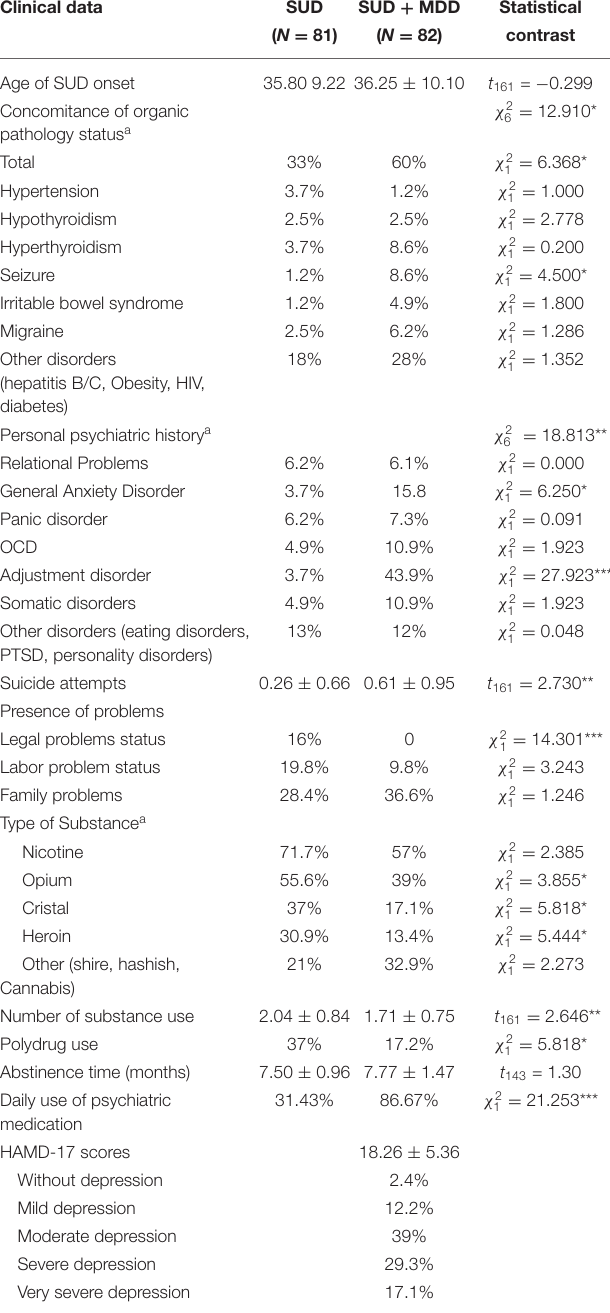
TABLE 2 | Clinical characteristics for SUD and SUD + MDD groups. Clinical data